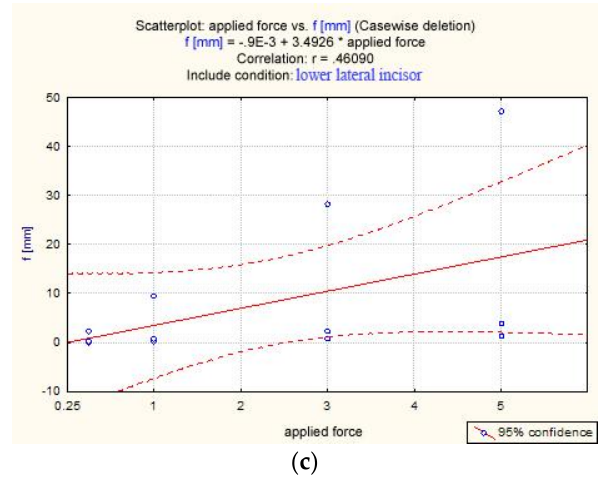
Figure 14. Regression line of the correlation ( a ) σ ech, ( b ) σ c, and ( c ) f vs. applied force.